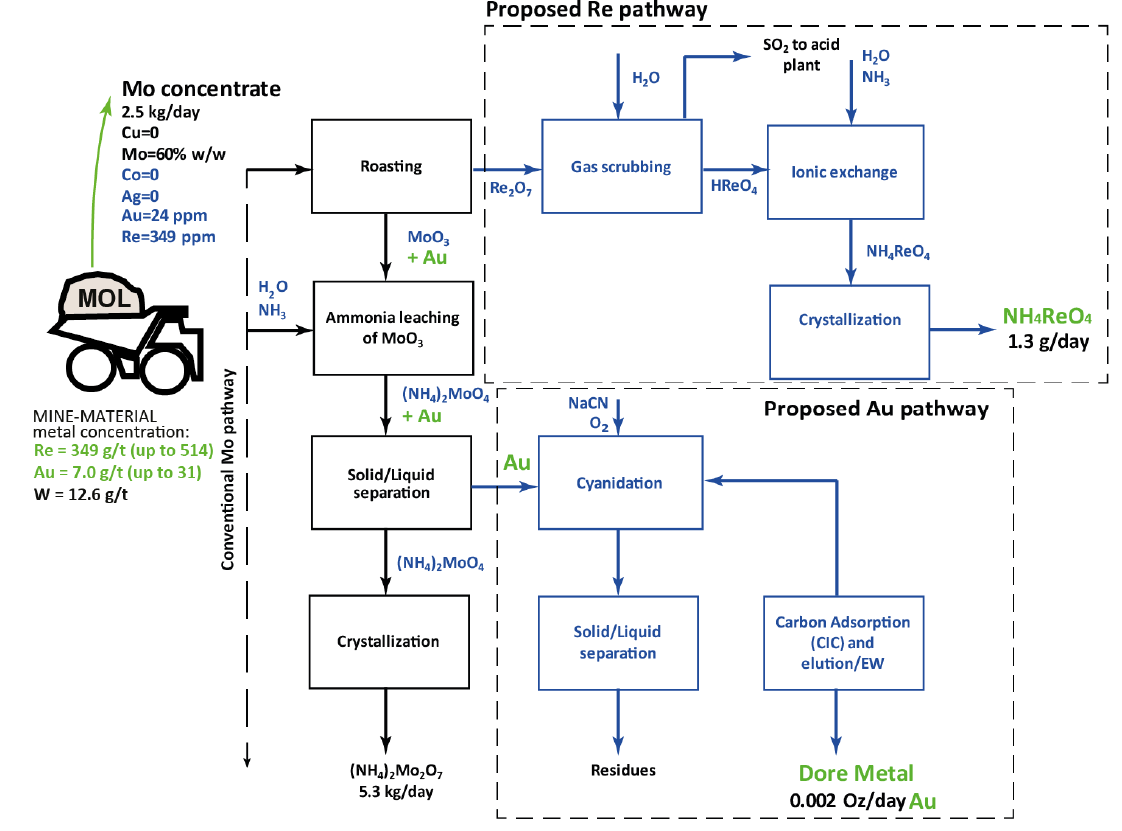
Figure 8. Schematic flow-sheet proposed to recover marketable critical and precious metals, such as Re and Au, in addition to Mo, from a molybdenite concentrate.